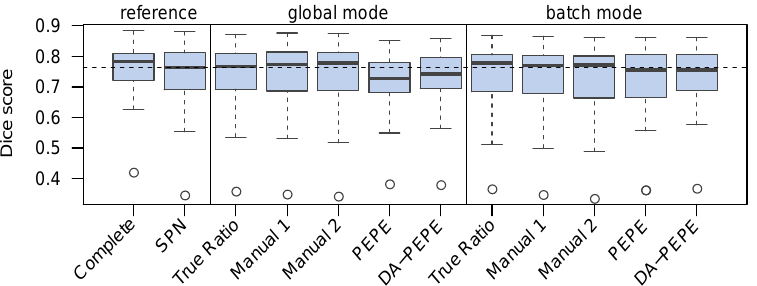
Figure 6. DICE scores for different leave-one-out configurations. All experiments except ’complete’ used importance weighting. The horizontal dashed line shows the median of the current state-of-the- art